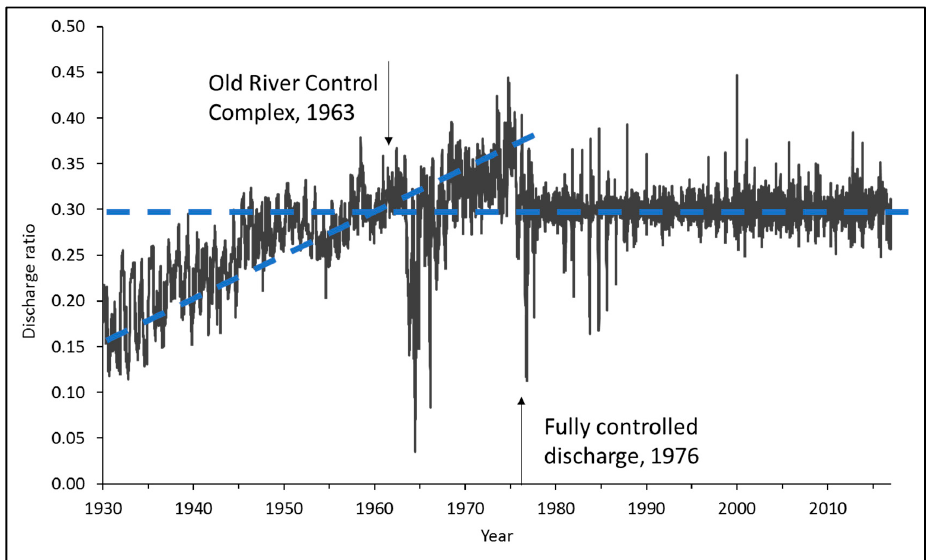
Figure 11. Discharge ratio between diversion Outflow Channel (tributary) and the Red River (main channel) of the Outflow Channel/Red River confluence during the period of 1855–2016. The increase was very likely linear because the discharge ratio increased linearly after 1930 showing in Figure 12.